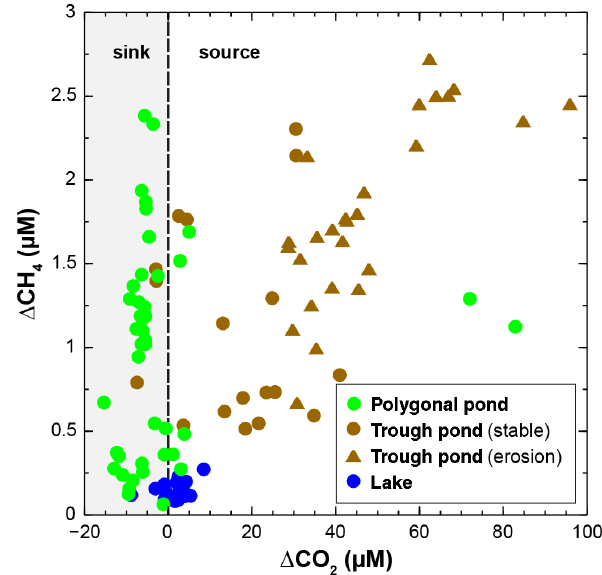
Figure 6. Saturation levels of dissolved GHG in pond and lake wa- ter. Values are expressed as the departure from saturation (in µM) for CO 2 ( x axis) and CH 4 ( y axis). Values < 0 indicate a sink, whereas values > 0 indicate a